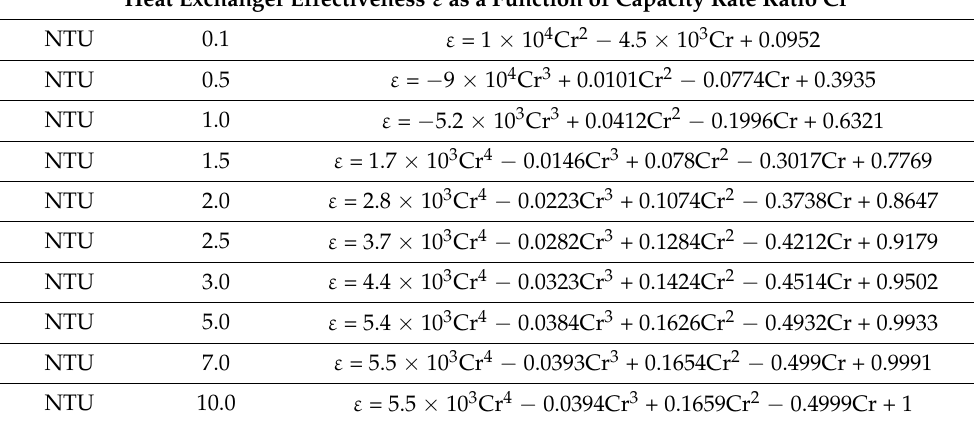
Table 2. Curve fit equations for effectiveness prediction—1-row pure cross flow heat exchanger. C min —External Fluid C max —Internal Fluid; sensible heat transfer.